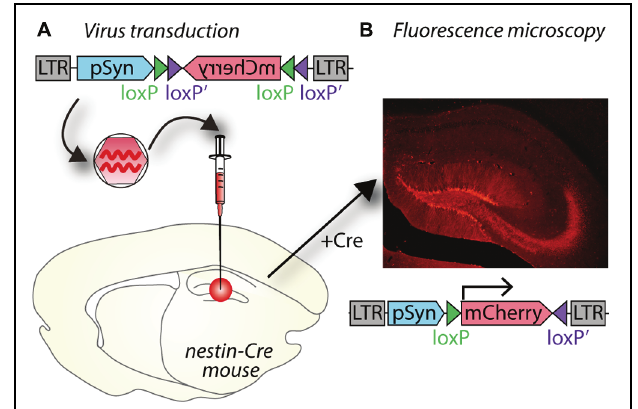
FIGURE 2 | A potential use of Cre–lox and cell specific promoters to target gene expression both spatially and temporally. (A) A lentiviral vector (LV- synapsin-double-floxed mCherry) injected in the hippocampal dentate gyrus (DG) of a nestin-cre mouse. (B) Cre expressed in nestin-positive neural progenitor cells reverses mCherry and allows expression in new neurons as they differentiate in granule neurons. mCherry expression is therefore restricted to granule neurons born after virus